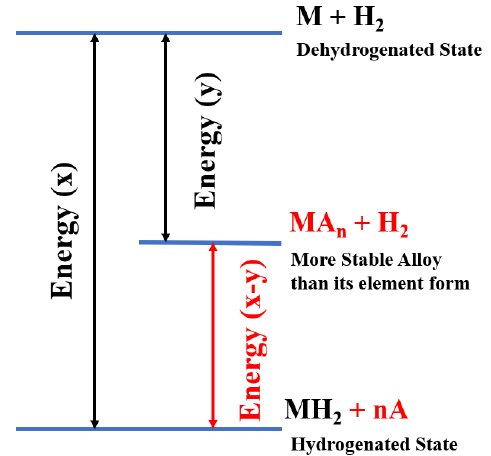
Figure 1. Schematic of destabilization process of a hydride MH using third element A. (Reproduced with permission from ref. [41]. Copyright 2016 Elsevier.)